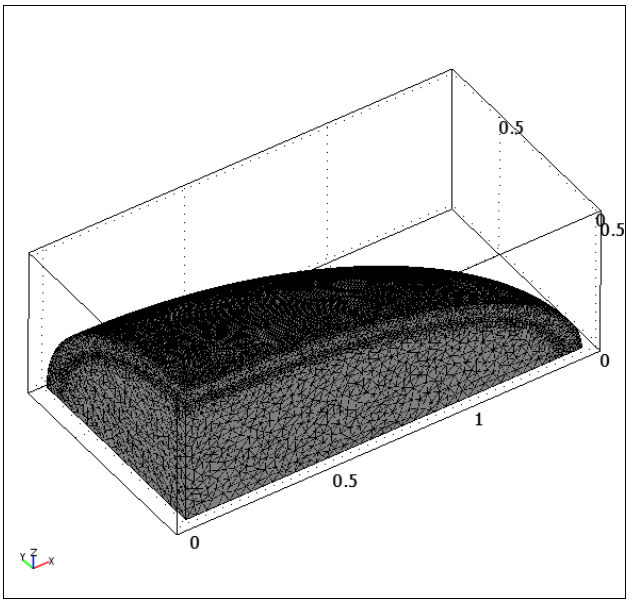
Figure 3. Representation of the computational domain (1/4 of the ellipsoidal bean) and the FEM (finite elements method) mesh